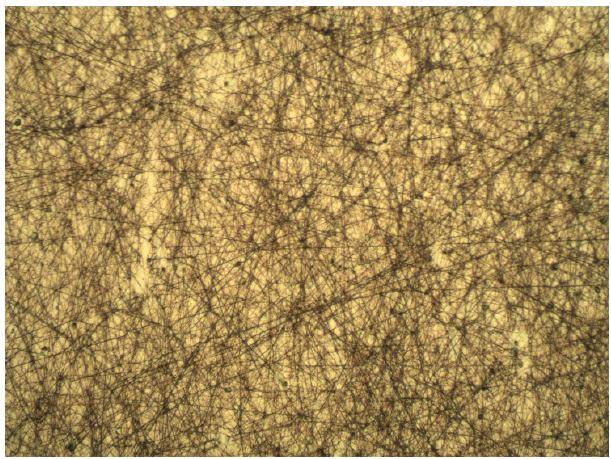
Figure 5. Optical microscope image of the electrospun aqueous extracts. 100× amplification.